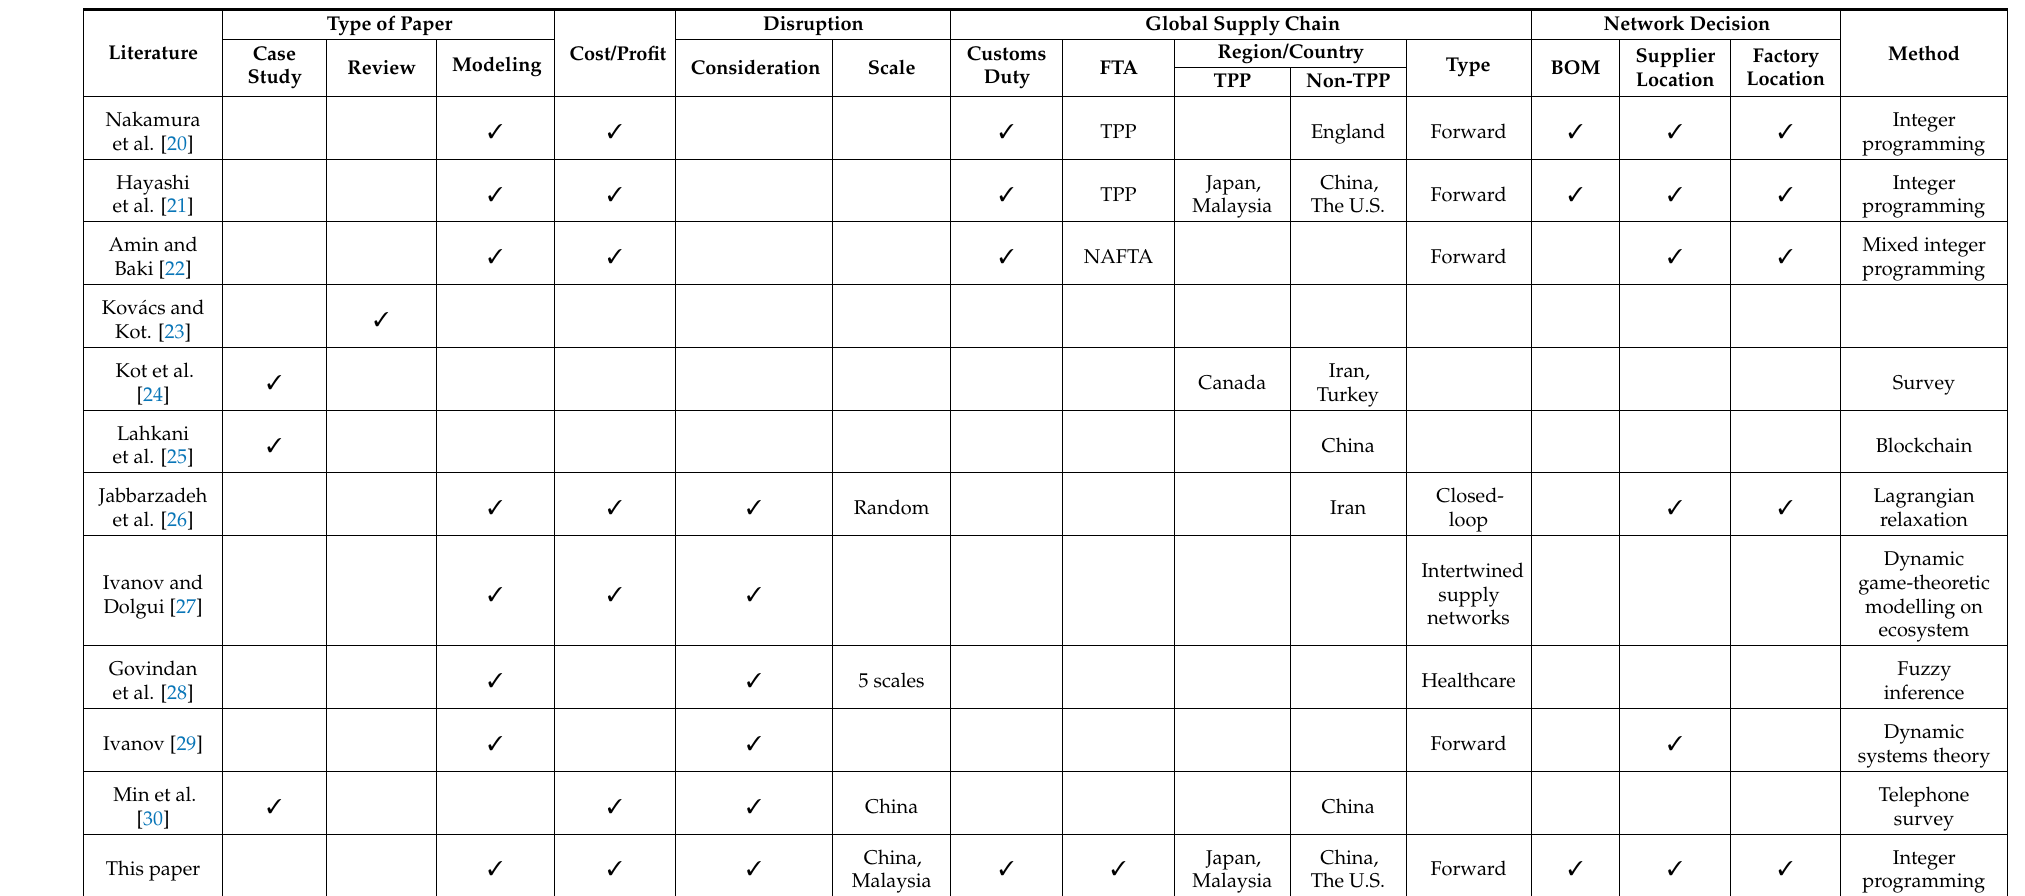
Table 1. Literature on supply chains and